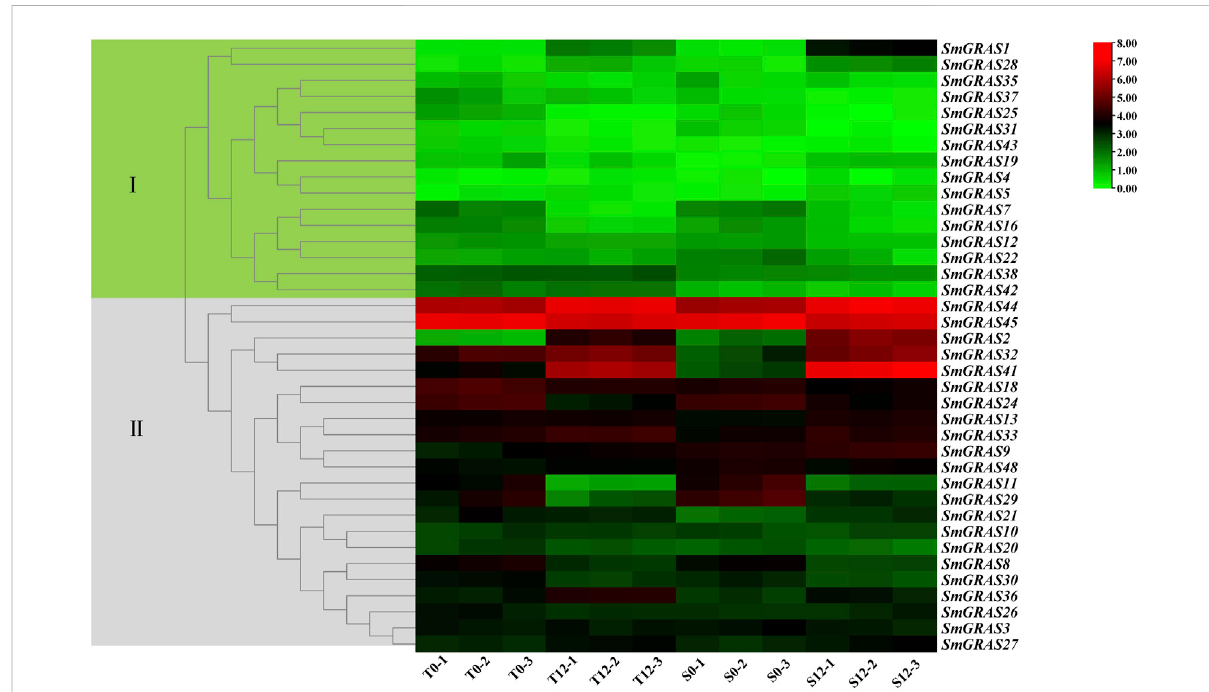
FIGURE 7 Expression changes of SmGRAS s under cold stress. S0 and T0 represent the sensitive and tolerant varieties before low-temperature treatment, respectively. S12 and T12 represent the sensitive and tolerant varieties after low-temperature treatment, respectively. This experiment was repeated three times. The genes on the right of the image correspond to the two color-coded boxes on the left.